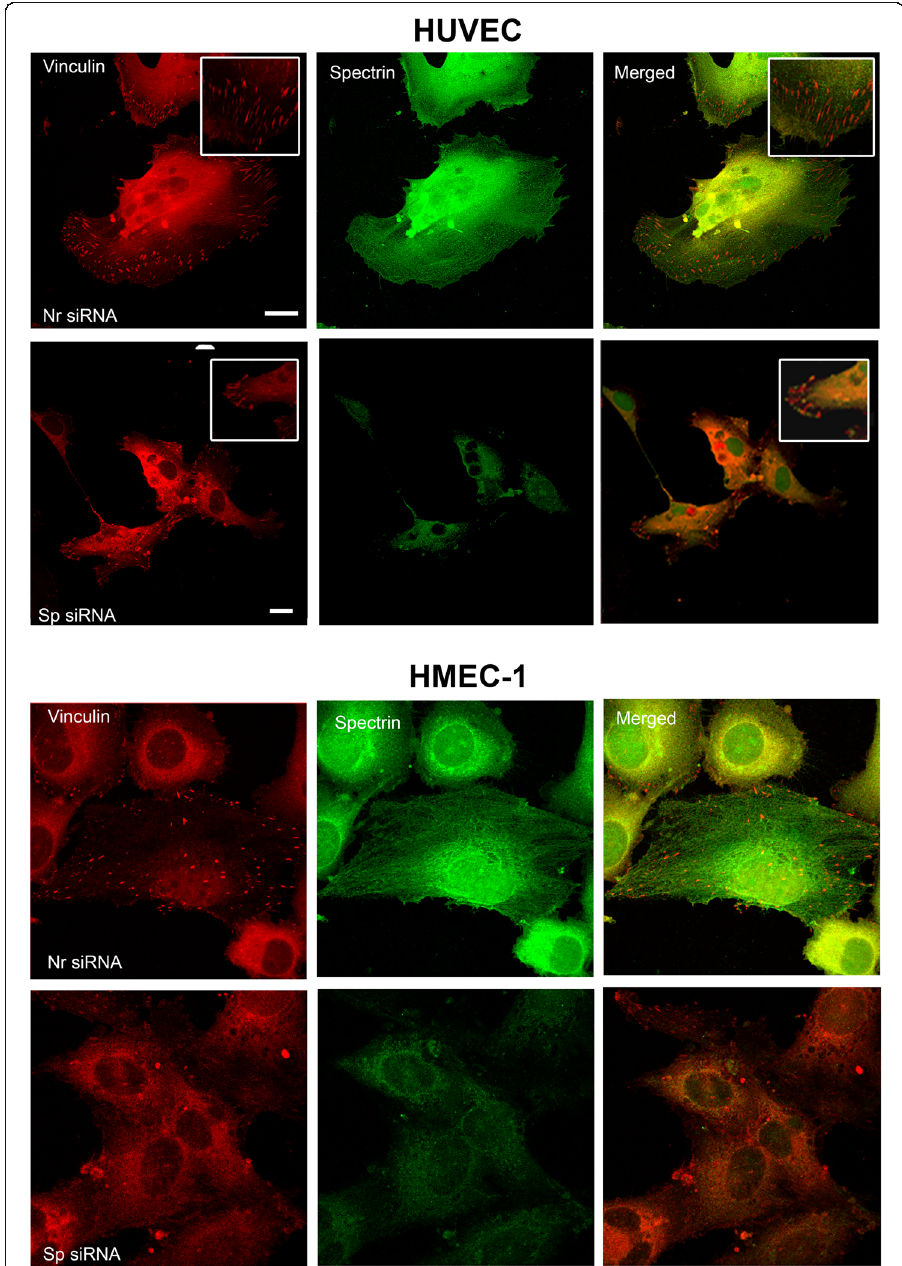
Fig. 4 Spectrin depletion modifies focal points in endothelial cells. Focal points were analyzed using monoclonal antibodies directed against vinculin (red) and polyclonal antibodies directed against α II-spectrin (green) on HMEC-1 cells and HUVECs 72 h after transfection with Sp siRNA or Nr siRNA. Spectrin-depleted cells exhibited a reduced number of focal points compared to Nr siRNA-treated cells. Scale bar = 20 μ